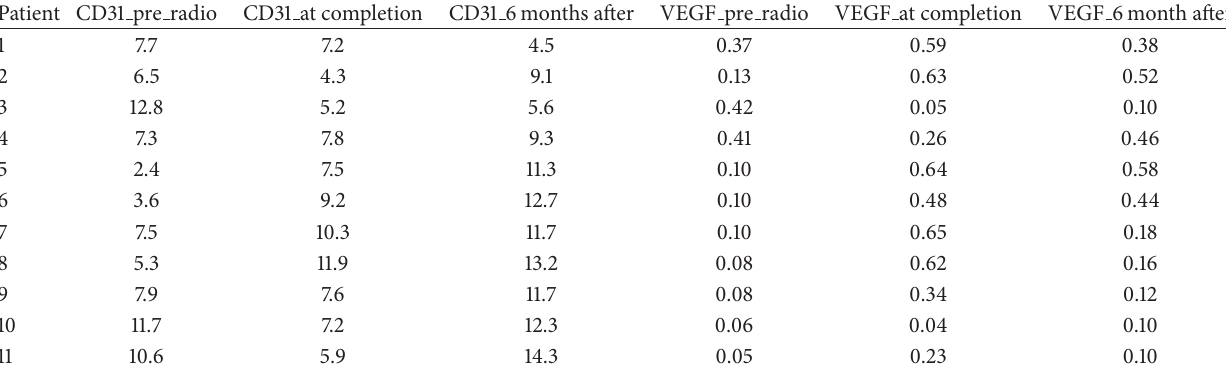
Table 2: Sequential change of VEGF and CD31 in an individual patient at three time settings—before, at the completion of, and 6months after